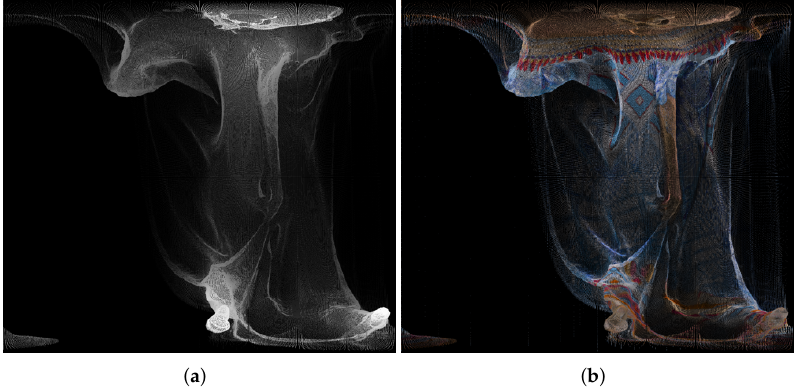
Figure 5. Panorama images created using point cloud “longdress_vox10_1060.ply” from the equirect- angular projection, for the geometry ( a ) and texture ( b